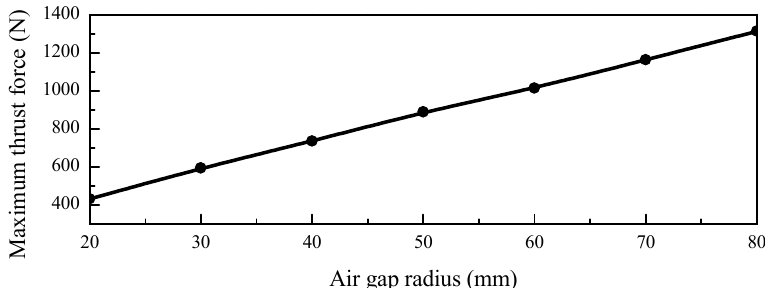
Figure 7. Variation in the maximum thrust force with different air gap radii.